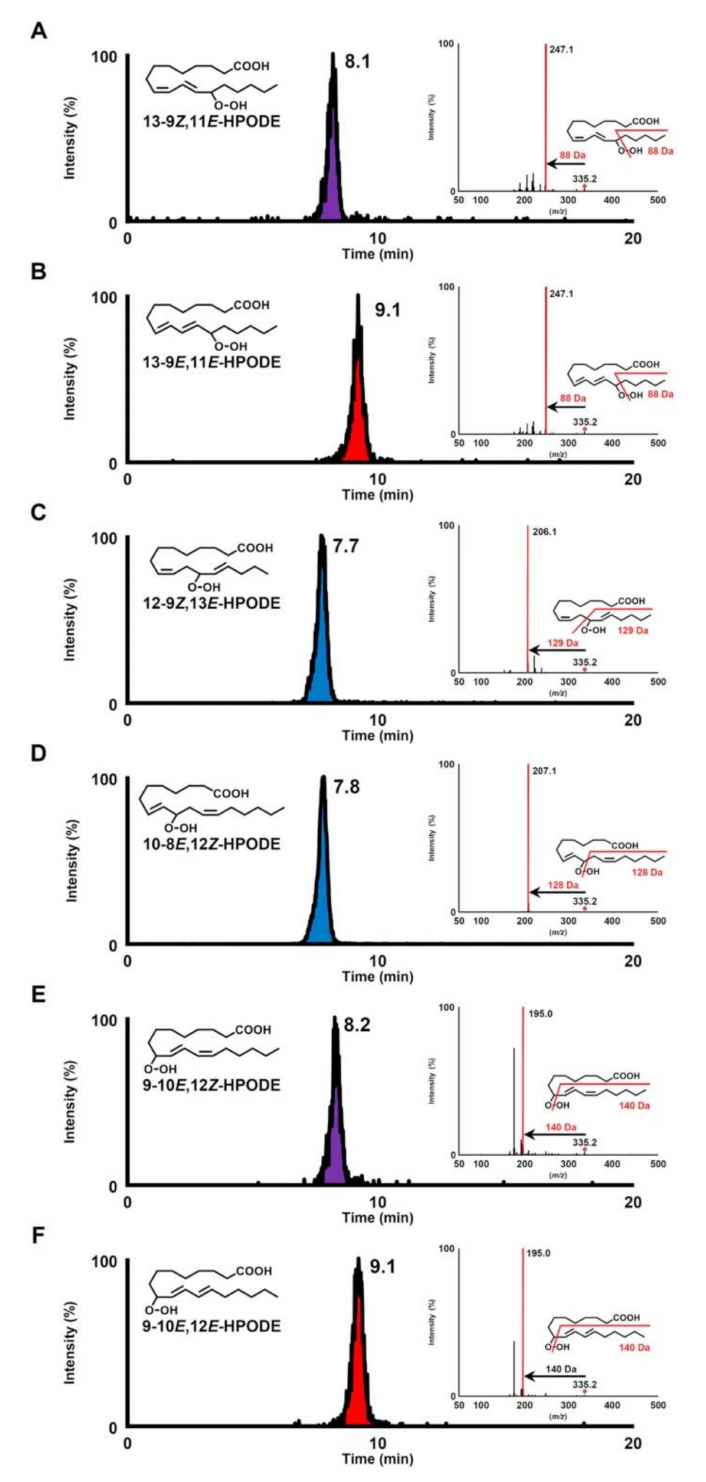
Figure 15. CSP-LC-MS/MS chromatogram and product-ion mass spectra (MS/MS) of stan- dard HPODE isomers, using a selected reaction-monitoring (SRM) mode, as follows: 13-9 Z ,11 E - HPODE and 13-9 E ,11 E -HPODE, m / z 335.2 > 247.1 ( A , B ); 12-9 Z ,13 E -HPODE, m / z 335.2 > 206.1 ( C ); 10-8 E ,12 Z -HPODE, m / z 335.2 > 207.1 ( D ); 9-10 E ,12 Z -HPODE and 9-10 E ,12 E -HPODE, m / z 335.2 > 195.1 ( E , F )